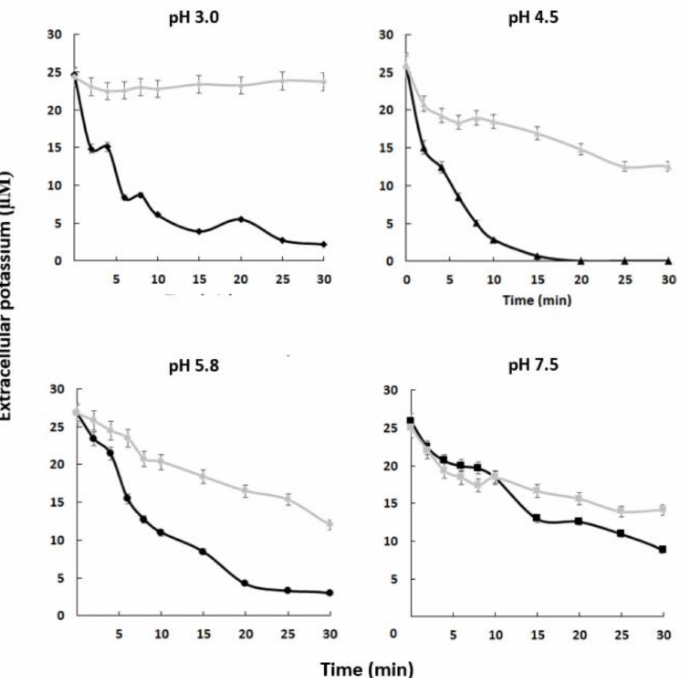
Figure 3. Absorption of external potassium in C. albicans HAK1+ and hak1 − strains. K + -starved cells were resuspended (A 600 0.5) in uptake buffer adjusted at the required pH (see the Materials and Methods) and containing 25–28 µ M K + approx. Samples of HAK1+ (black) and hak1 − (gray) cells were taken at the indicated times, filtered, and K + in the medium was measured. Mean values ± standard deviation obtained in three independent experiments are